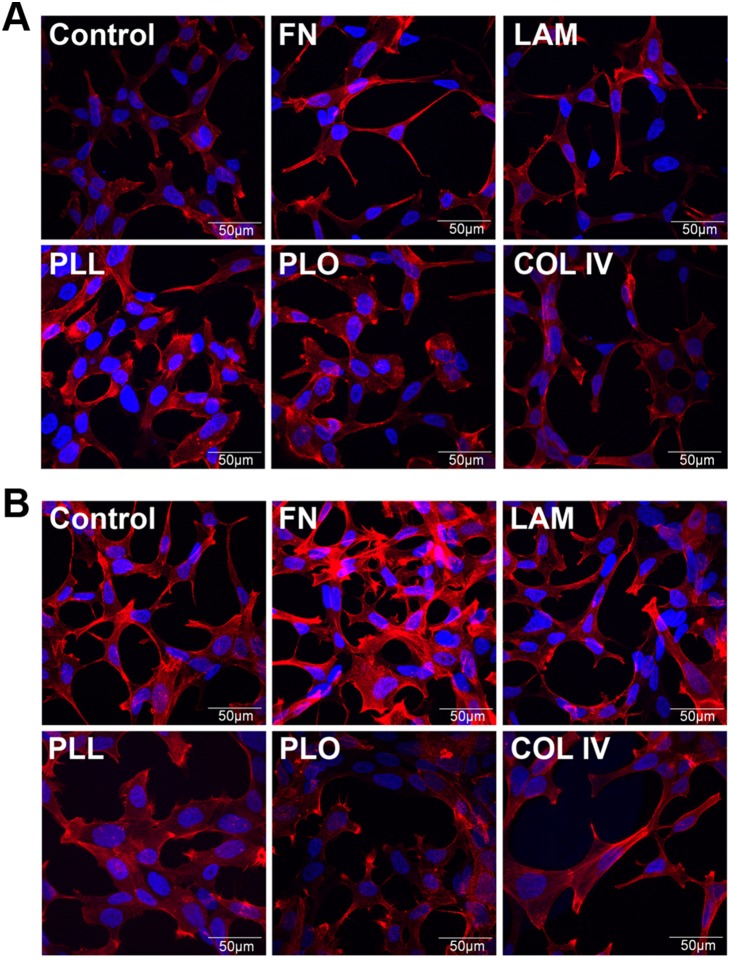
Immunofluorescence of LNCaP cells stained for F-actin.Cells were grown on glass cover slips without coating (control), or coated with fibronectin (FN), laminin (LAM), poly-l-lysine (PLL), poly-l-ornithine (PLO), or collagen type IV (COL IV). After 24 h (A) or 96h (B), cells were stained for F-actin with rhodamine-phalloidin, counterstained with DAPI, and analyzed by confocal fluorescence microscopy (60×, Olympus). Arrows indicate lamellipodia of polarized cells and arrow heads mark filopodia. Scale bar = 50 µm.